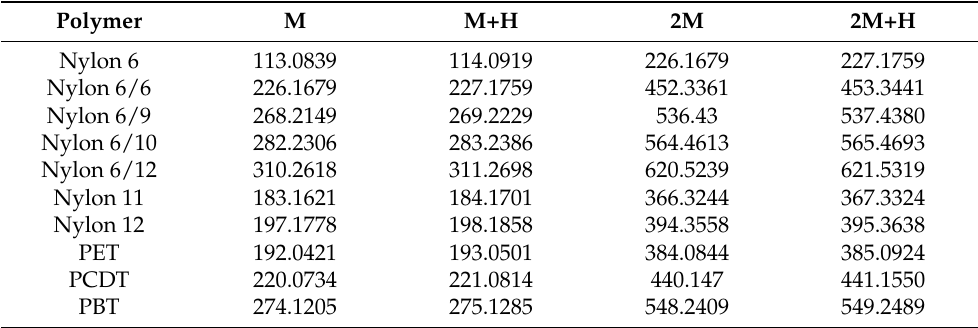
Table 3. Calculated exact masses of the monomers and dimers of nylons and polyesters, as well as their protonated exact